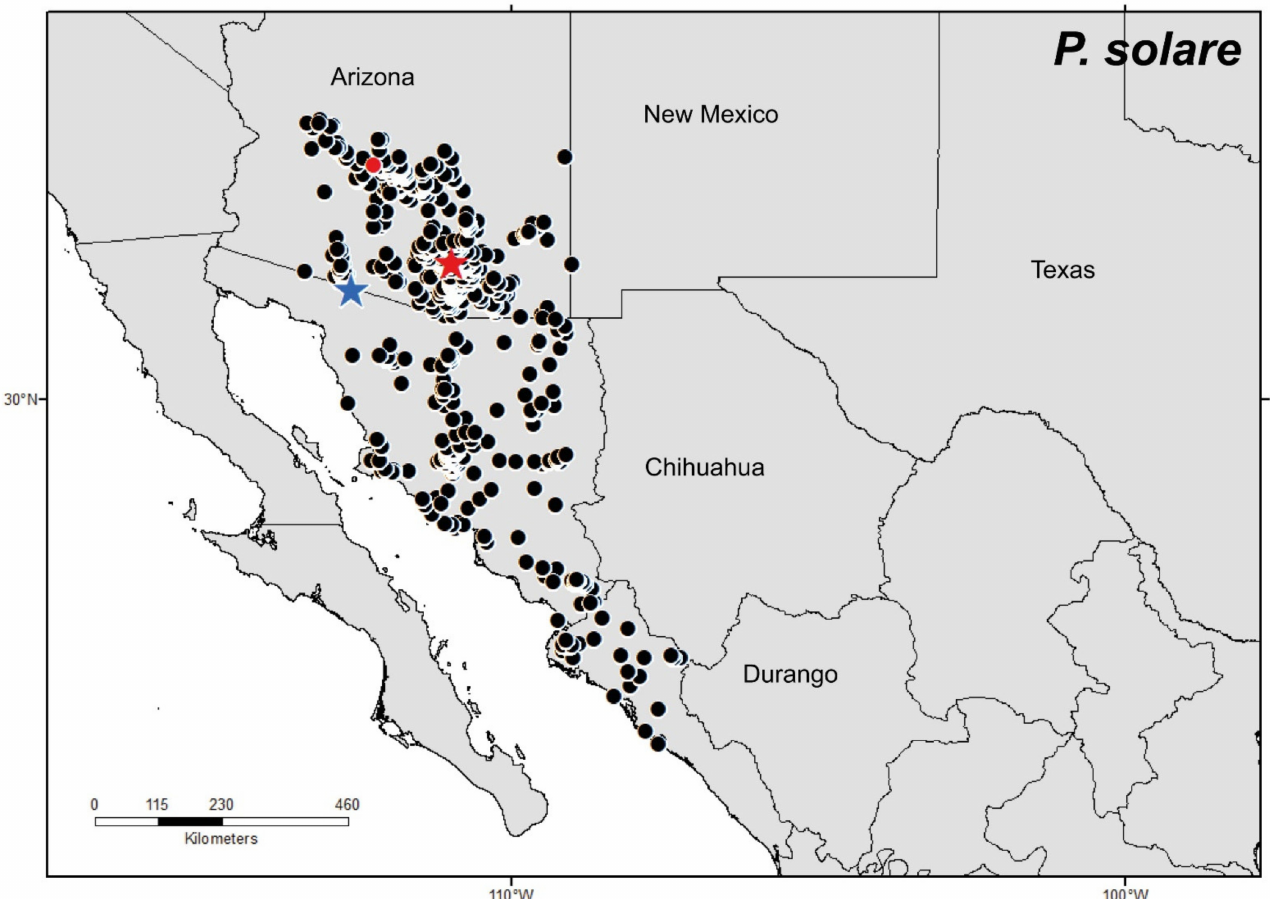
Figure 17. Map showing distributional records of Phrynosoma solare . Red circles = genetically confirmed records; black circles = records that have not been genetically confirmed; red star = restricted type locality of P. solare ; blue star = restricted type locality of P. regale